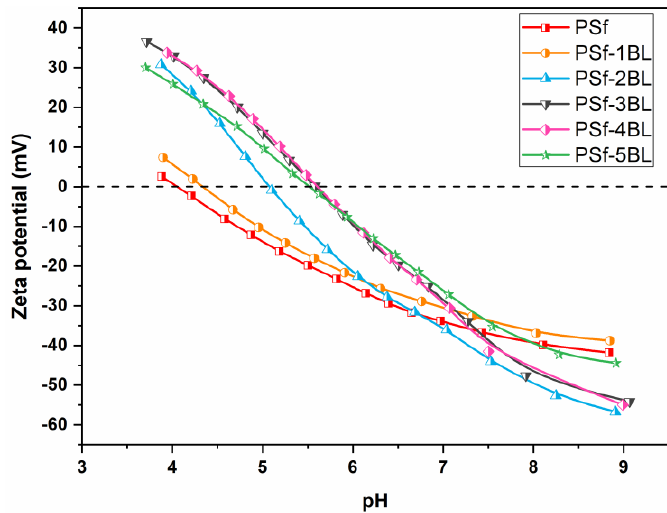
Figure 4. Plots of Zeta potential of nascent and modified PSf membranes versus pH.